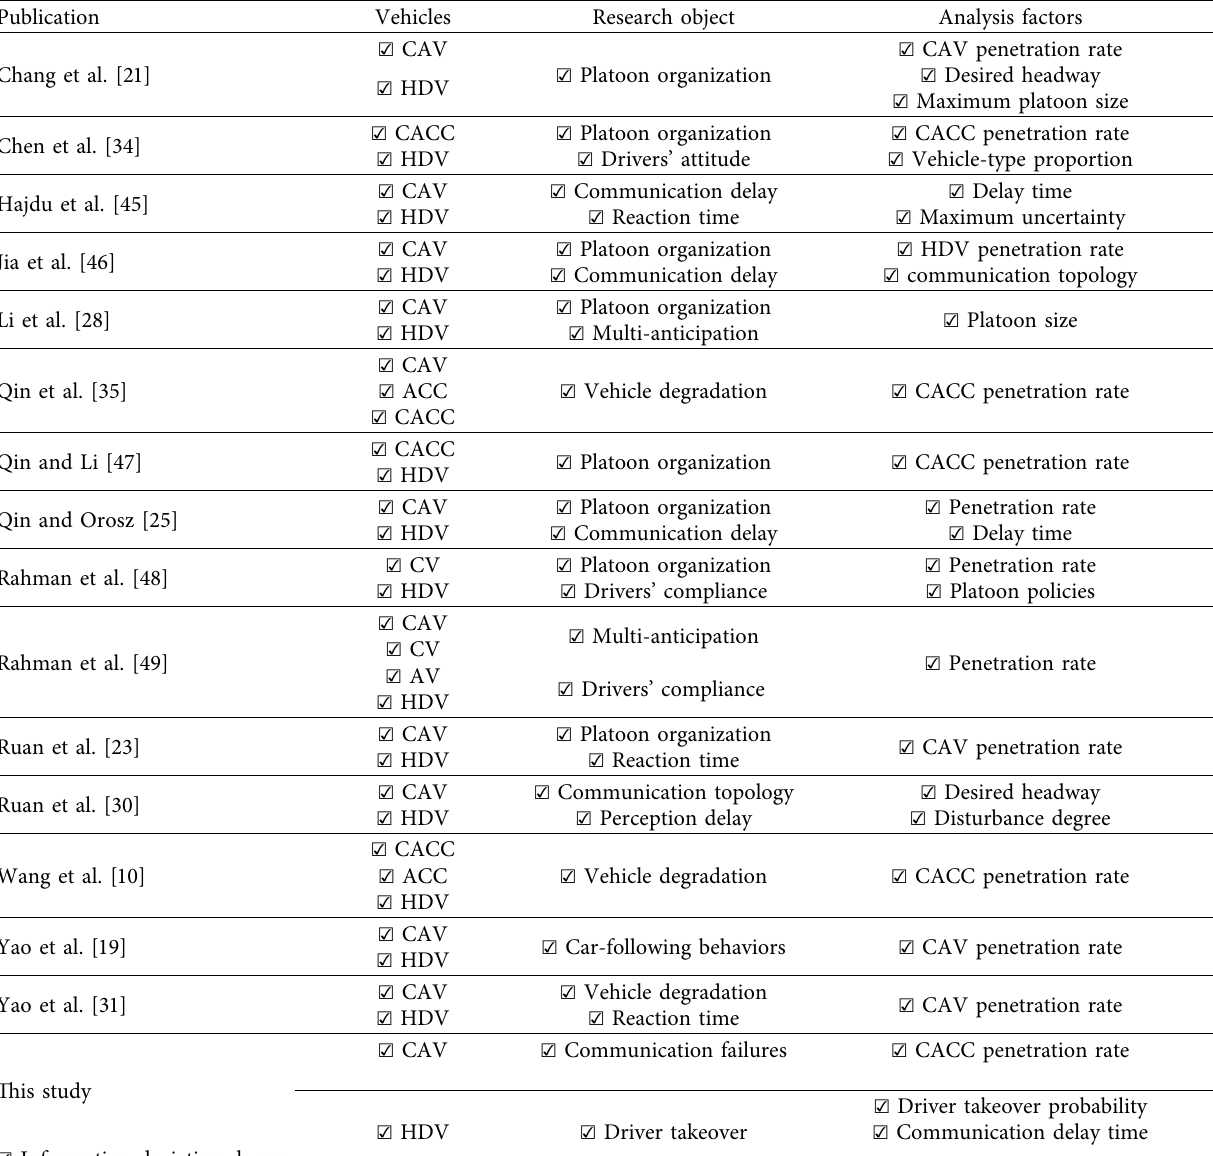
Table 1: Literature summary on the stability analysis of heterogeneous traffic